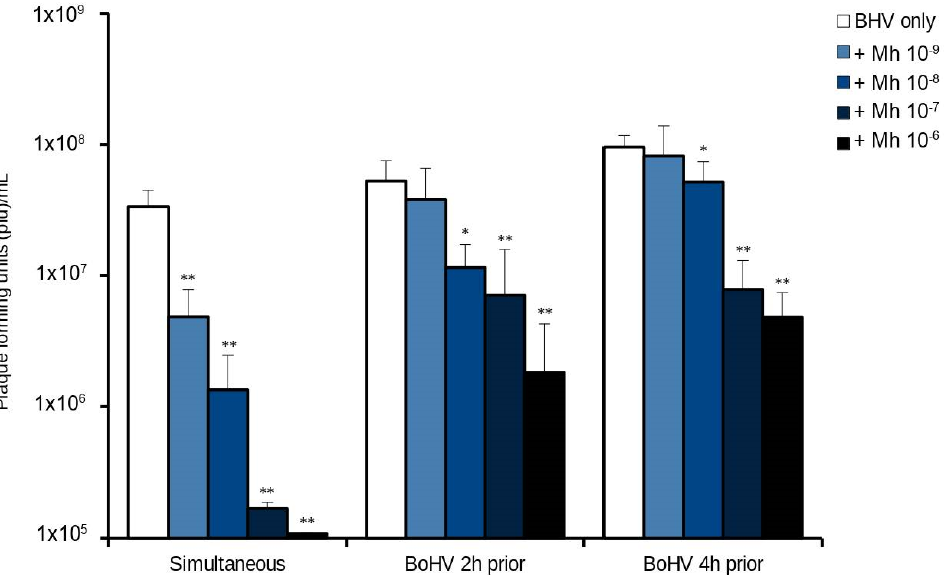
Figure 3. Timing of the BoHV-1— M. haemolytica co-infection is important. BoHV-1 (MOI 1) was added either simultaneously, 2 h or 4 h prior to adding increasing doses of M. haemolytica (dilutions 10 − 6 –10 − 9 ). Viral replication was assessed by plaque assay (pfu/mL). Significance levels between the means were tested by comparing against the “BoHV only” infection in each group (*, p < 0.05; **, p < 0.01).